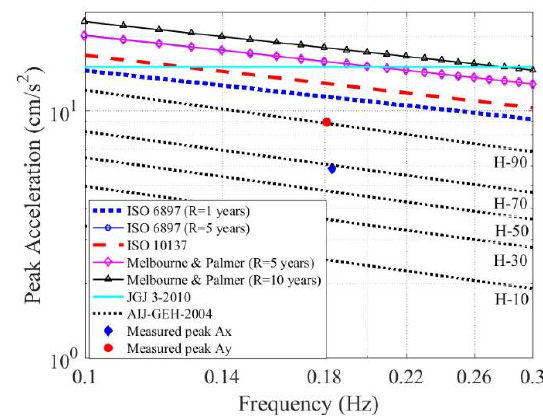
Figure 8. Comparison of measured maximum acceleration responses with those recommended by different comfort criteria.